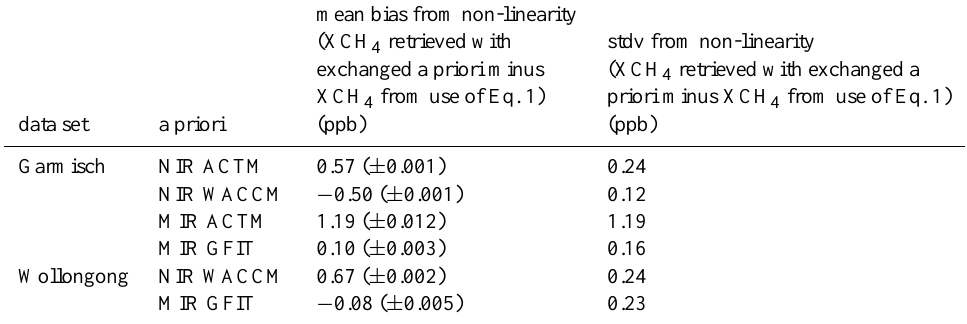
Table A1. Impact of non-linearity on XCH 4 from using Eq. (1) for a posteriori exchange of an a priori profile versus performing a retrieval with exchanged a priori. Data basis is retrievals from individual MIR and NIR spectra, from same-day NIR–MIR coincidences. Uncertainties are 2 times the standard errors of the mean (2- σ /sqrt ( n))